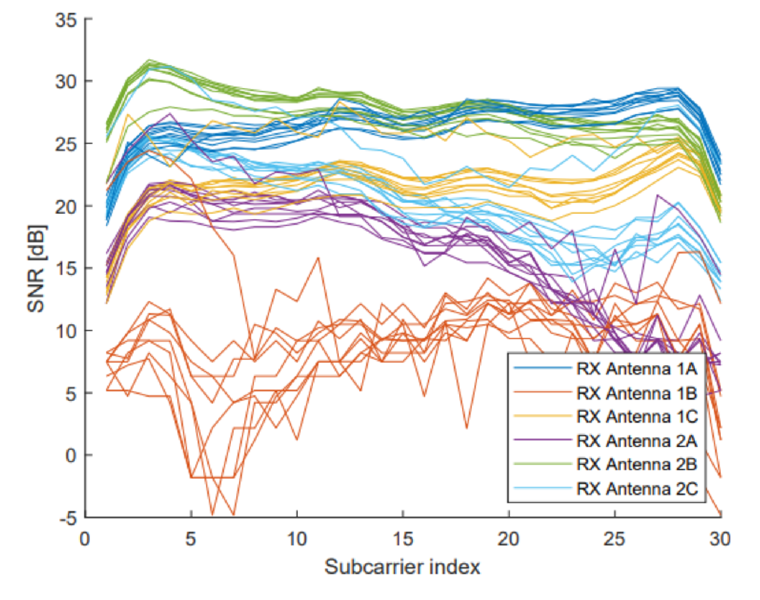
Figure 2. Amplitude representation in a 2 × 3